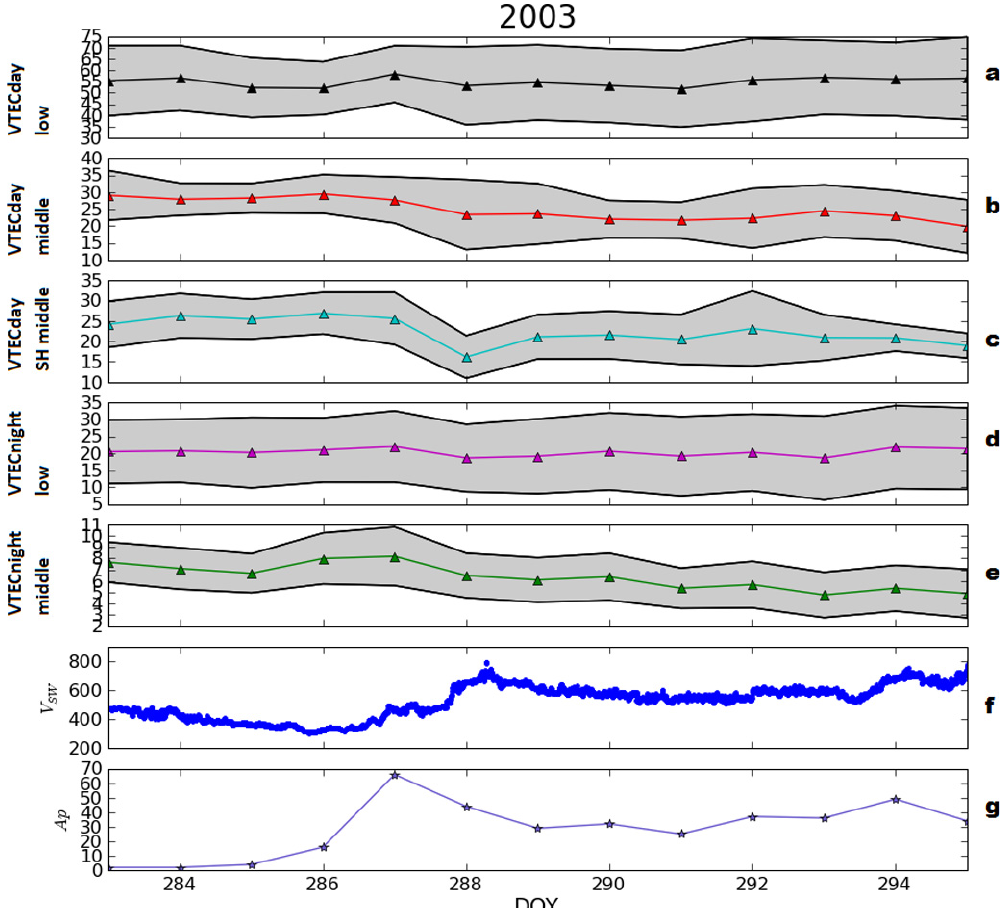
Fig. 3. The same format as in Fig. 1 but for the 2003 HSS event 1: 10–22 October 2003.